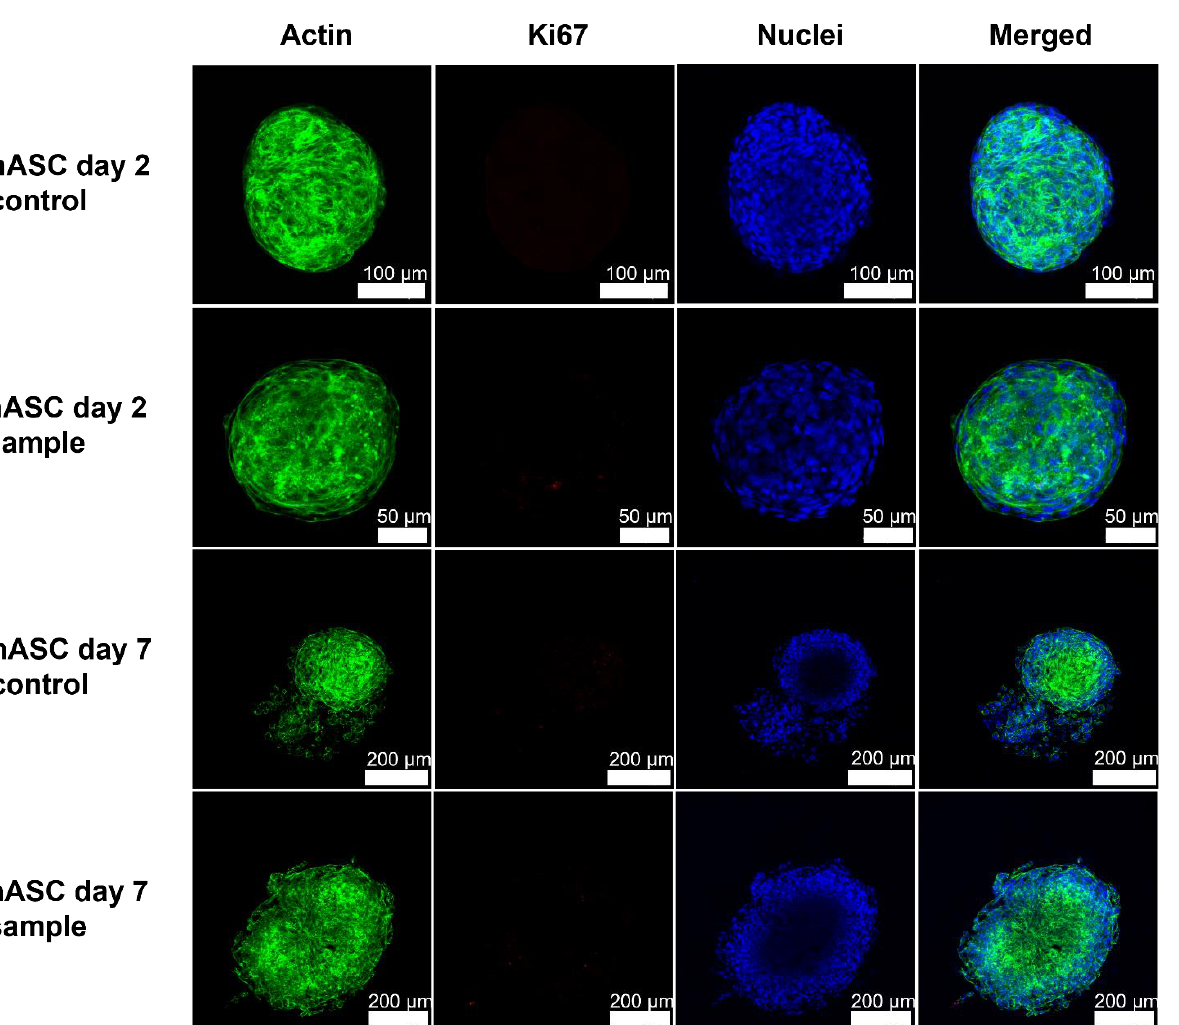
Figure 5. Immunocytochemical staining showing an organized structure of actin (green) and polar- ization of the cell observed as the shape of the nuclei (blue) of human adipose stromal/stem cells (hASCs) in fresh 0.125% NFC hydrogel (control) and freeze-dried and reconstituted 0.125% NFC hydrogel (sample). Proliferating cells (red) were observed only sparsely on both days 2 and 7. Green: Phalloidin conjugated Alexa Fluor 488. Red: Alexa Fluor 594. Blue: DAPI.